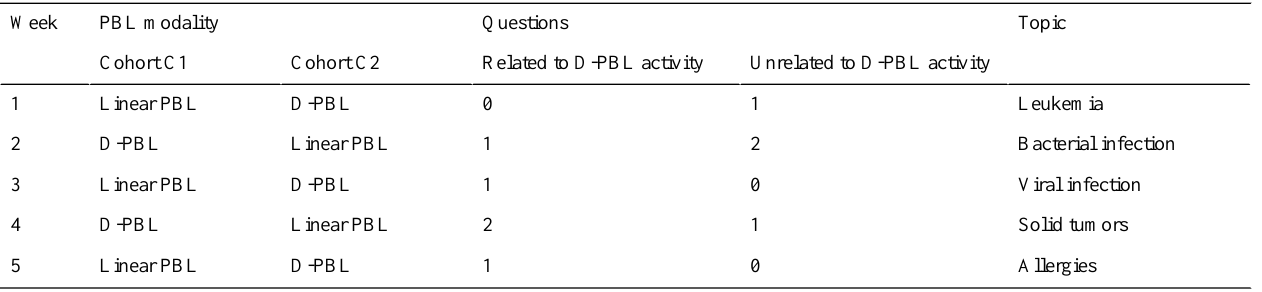
Table 1. Exam questions used in the study mapped to the problem-based learning (PBL) case week in the Life Protection module and to the 2 cohorts’ PBL modality (linear or decision-PBL; D-PBL) in each week of the module demonstrating a spread of questions over time and between cohorts.